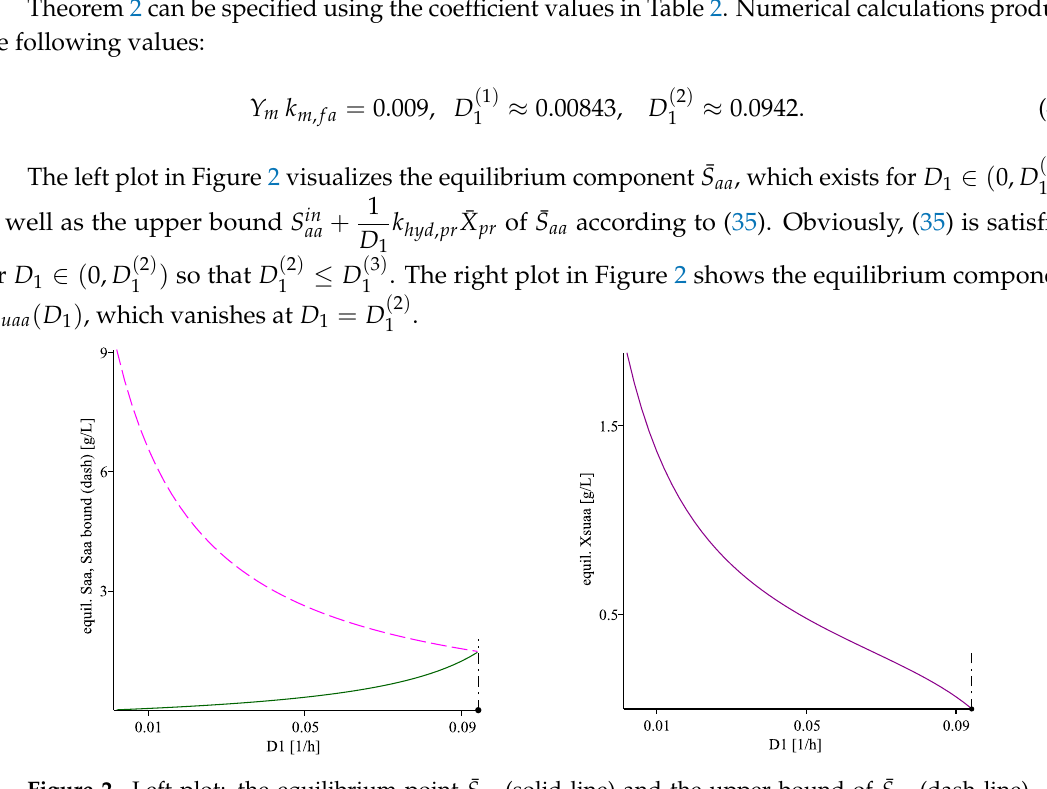
Figure 2. Left plot: the equilibrium point ¯ S aa (solid line) and the upper bound of ¯ S aa (dash line) according to (35) as functions of D 1 . Right plot: the graph of the equilibrium point ¯ X suaa . The vertical ( 2 ) dash-dot lines pass through D 1